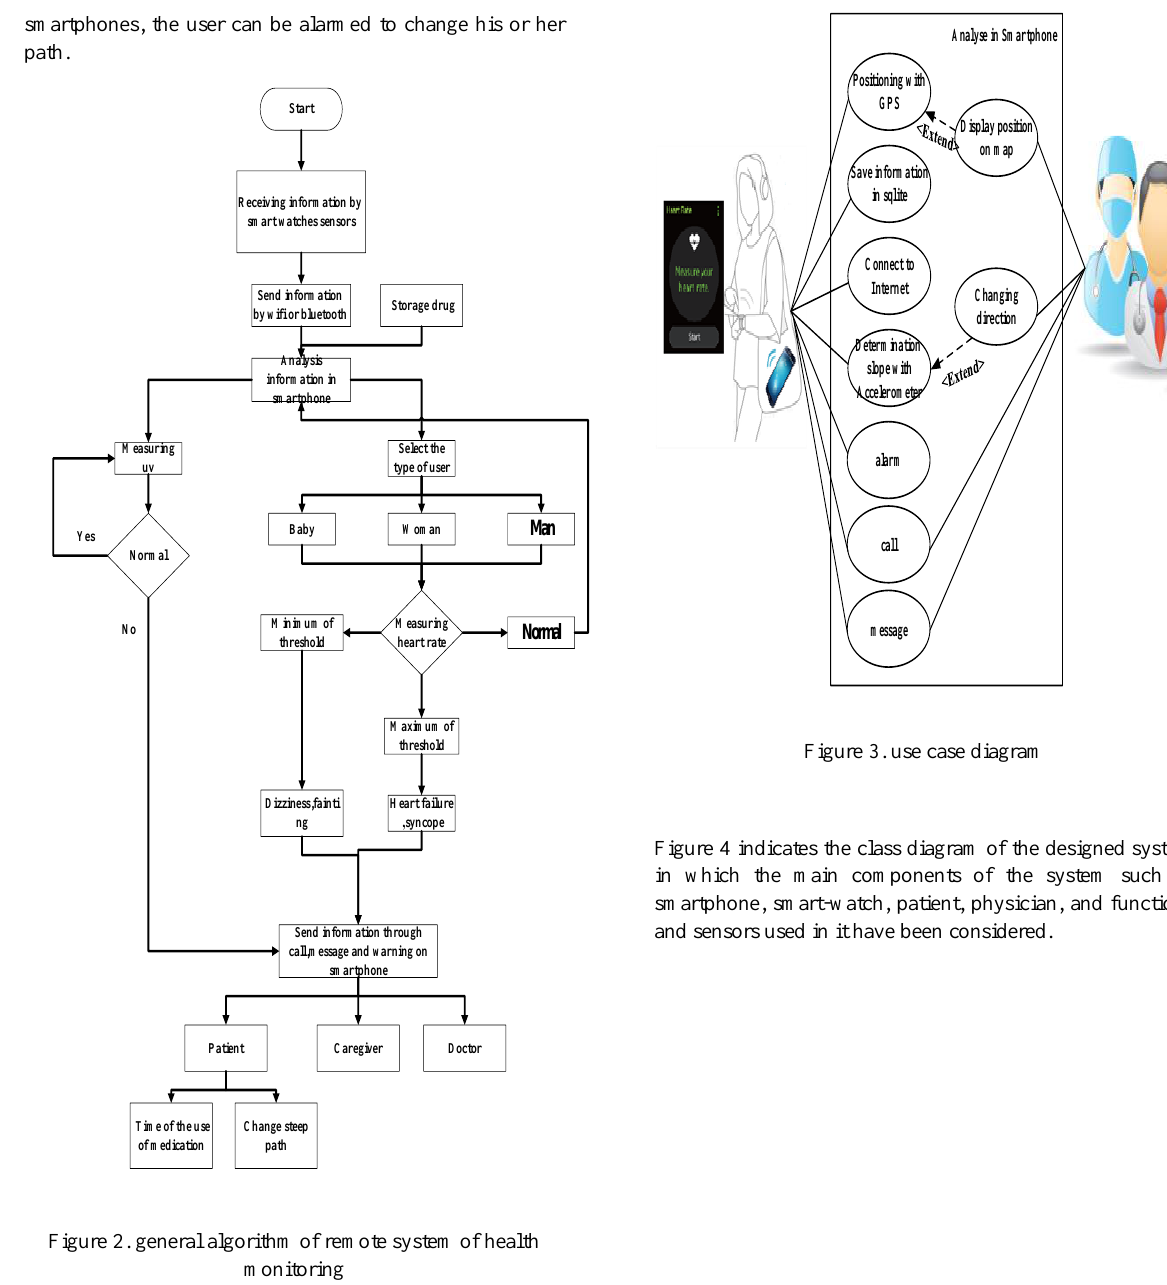
Figure 2. general algorithm of remote system of health monitoring Figure 3 indicates the analyses conducted between the patient and his physician in smartphone in a use case diagram.